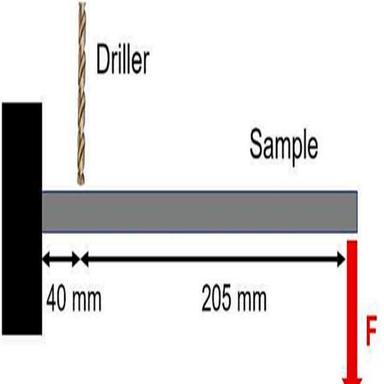
Sketch of experimental set-up used for validating the residual stress measurements for the GFRP/steel/GFRP laminate.